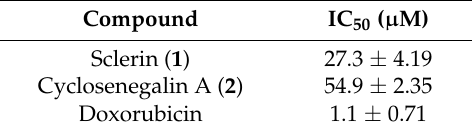
Table 2. In vitro growth inhibitory activity for compounds sclerin ( 1 ) and cyclosenegalin A ( 2 ) against human prostate carcinoma cell line